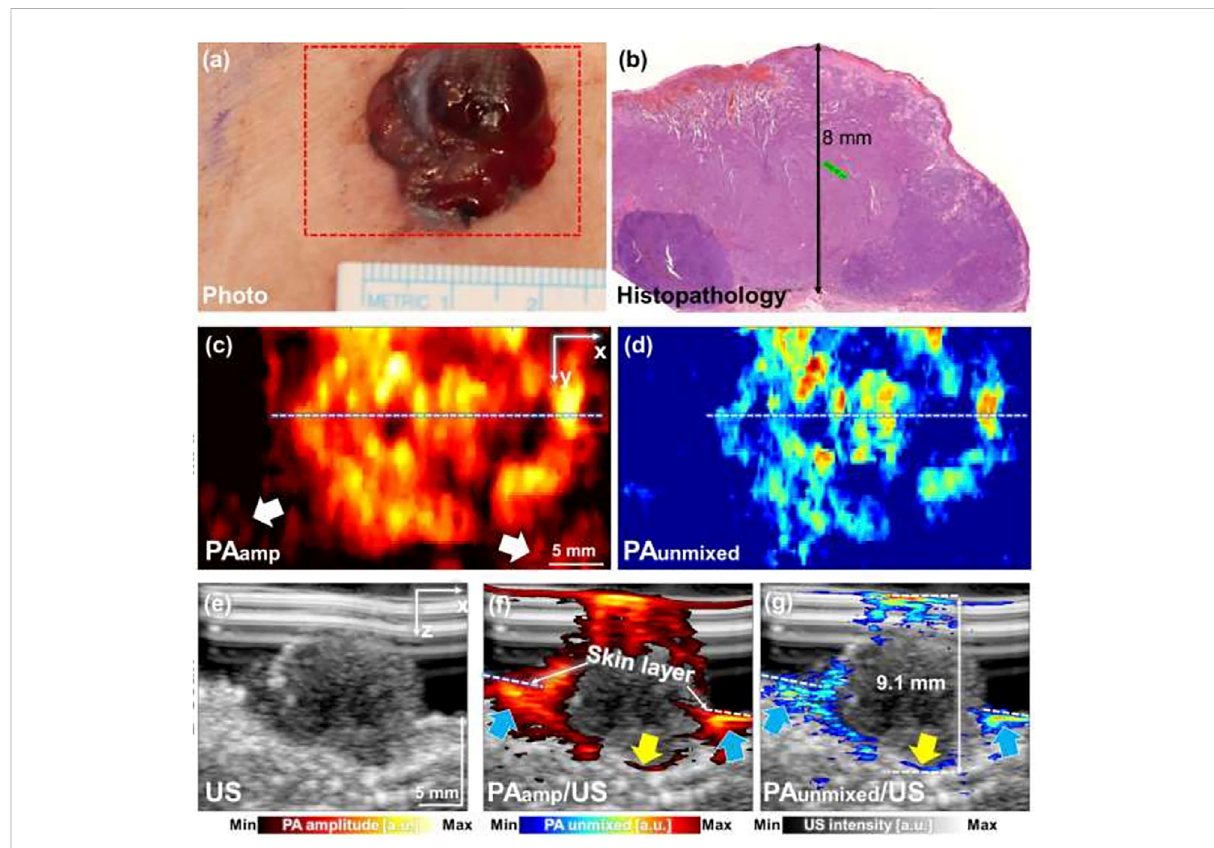
FIGURE 5 Combined PAT/US imaging of skin cancers. PAT image of a skin melanoma acquired simultaneously with a US image. (A) Clinical photo and (B) histopathologyof melanoma on human chest, (C) PAamp MAP and (B) PAunmixed MAP images along thearea ofred dashed box in (A) ; (E) USimage of melanoma; (F) PAamp/US image and (G) PAunmixed/US image along the white dashed lines in (C,D) , respectively. PAT: photoacoustic tomography; US: ultrasound; PAamp, photoacoustic amplitude; PAunmixed, photoacoustic unmixed melanoma; MAP, maximum amplitude projection. Reprinted with permission from Park et al.